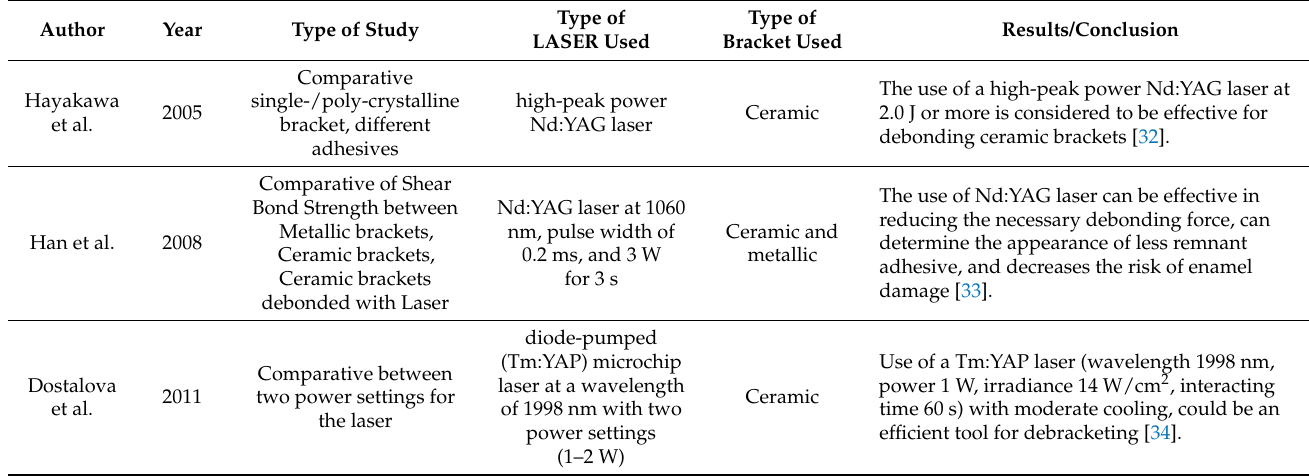
Table 3. Studies using Nd:YAG, Diode and fiber-laser